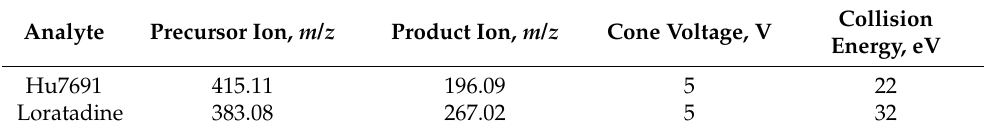
Table 1. Mass spectrometry detection conditions for Hu7691 and IS. Analyte